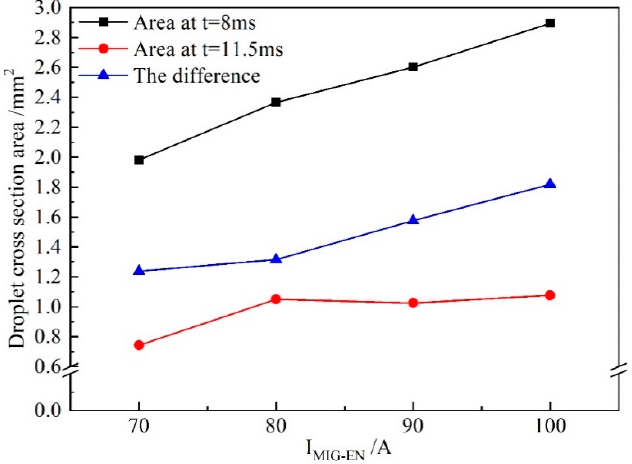
Figure 12. The difference between droplet cross-sectional area when I VPPA is changed and I MIG-EN is maintained at 70 A, at 8 and 11.5 ms.